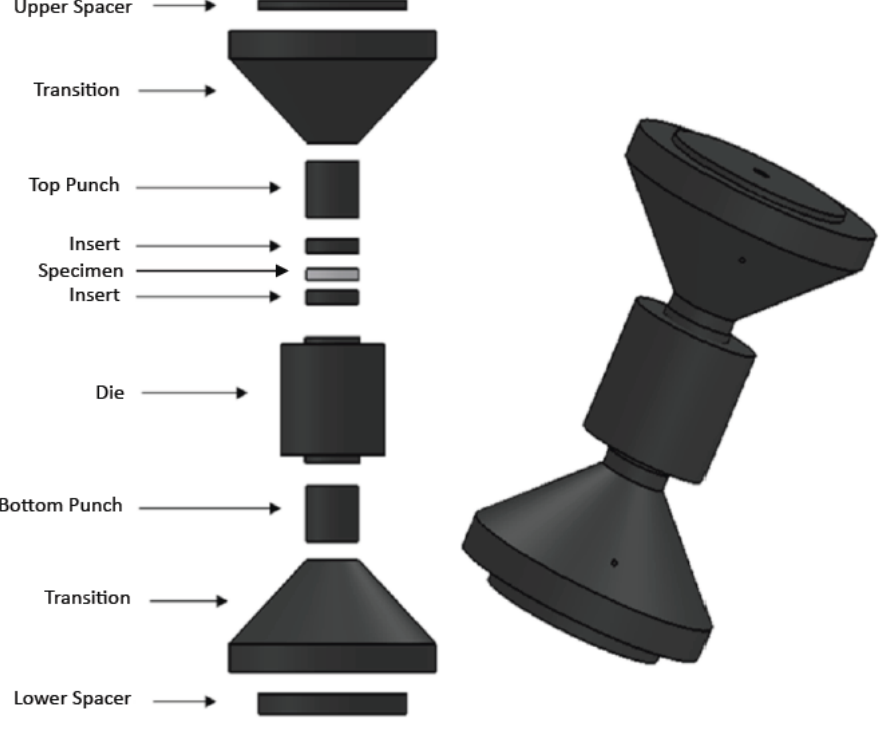
Figure 1. Spark Plasma Sintering (SPS) tooling manifesting the overheating